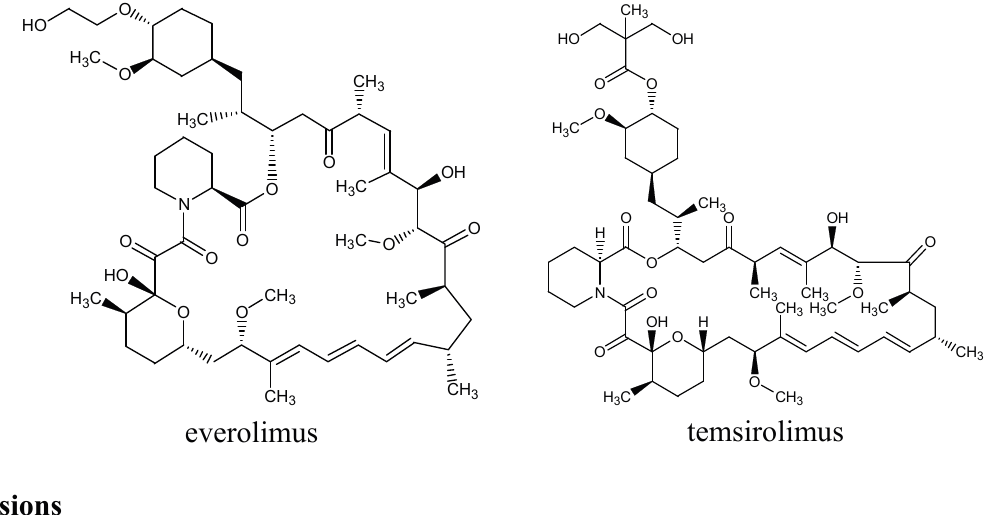
Figure 4. Chemical structures of mammalian target of rapamycin (mTOR) inhibitors with potential activity in diffuse large B-cell